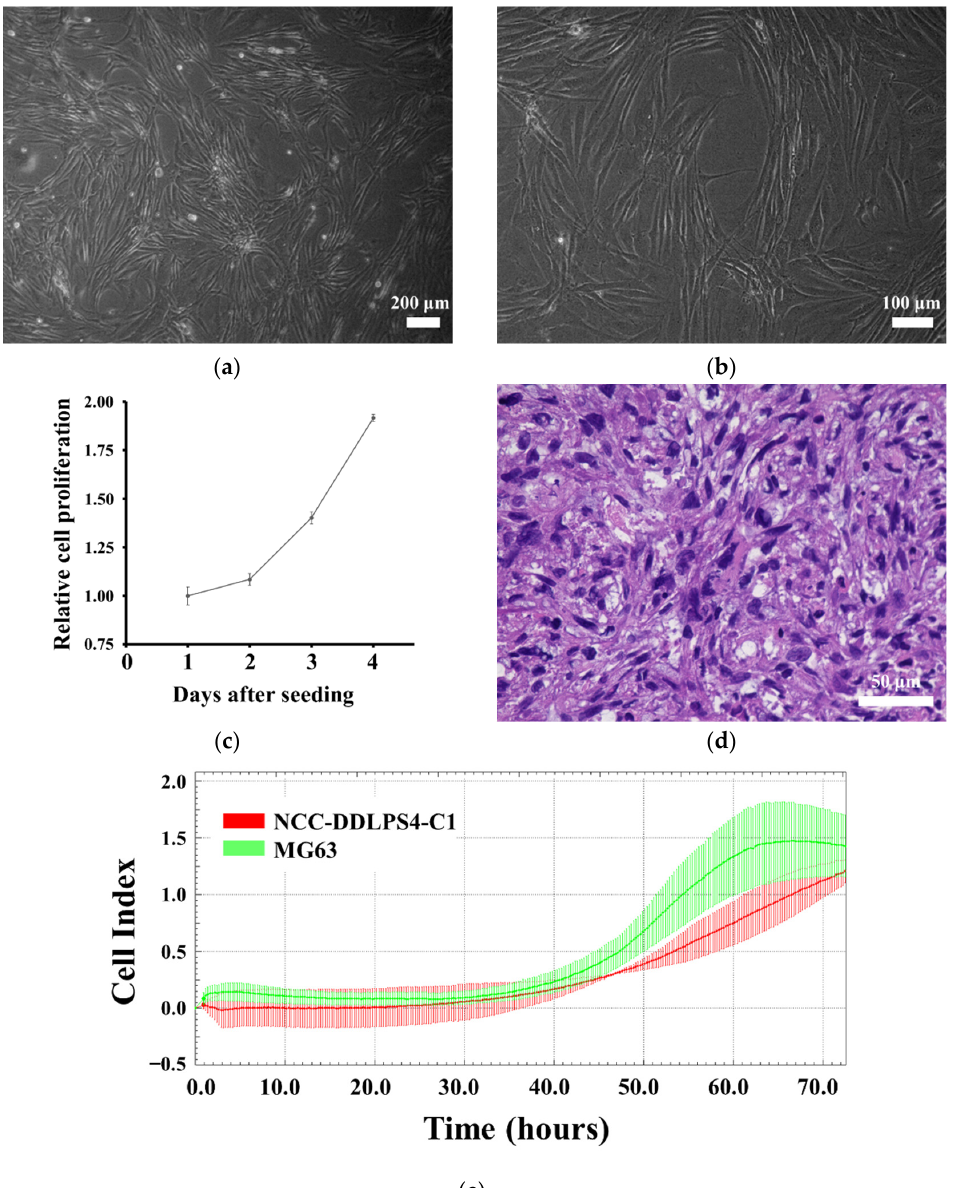
Figure 4. In vitro features of NCC-DDLPS4-C1 cells. ( a , b ) NCC-DDLPS4-C1 cells showing elongated spindle cell under culturing conditions; ( c ) growth curve of NCC-DDLPS4-C1 cells. The X -axis and Y -axis indicate the relative cell proliferation of NCC-DDLPS4-C1 cell and the day after seeding, respectively; ( d ) the spheroid consisting of pleomorphic spindle cells with nuclear atypia in hematoxylin and eosin stained section; ( e ) the invasion ability of NCC-DDLPS4-C1 cells compared to that of MG63 osteosarcoma cells.